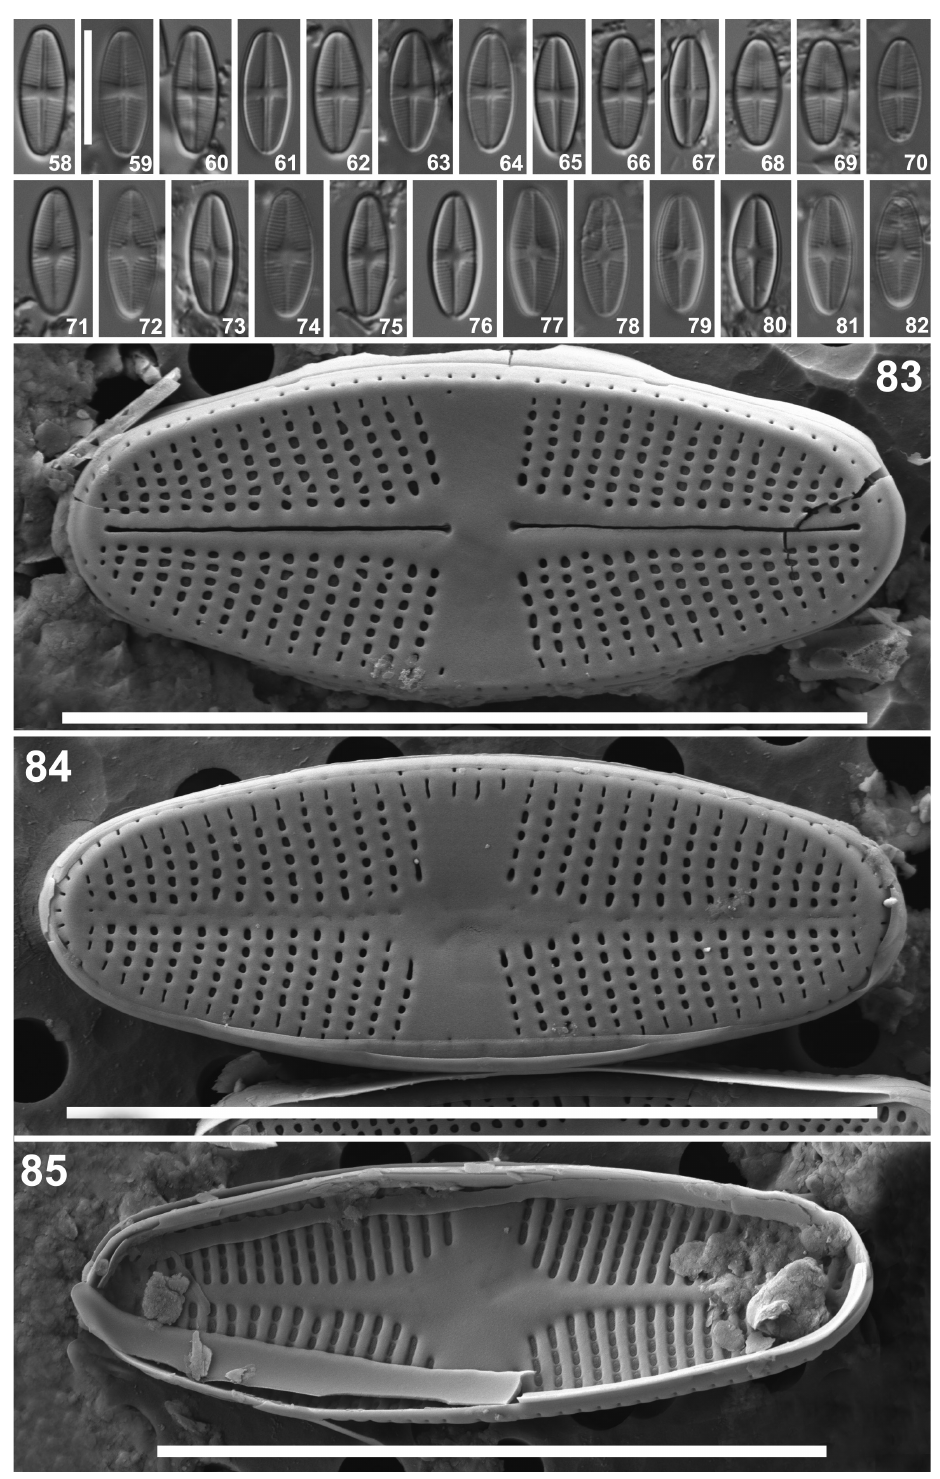
Figs 58–85. Psammothidium confusoneglectum Kopalová, Zidarova & Van de Vijver sp. nov. Light and scanning electron micrographs of the type population on Byers Peninsula (Livingston